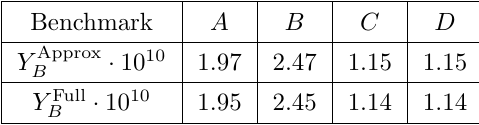
Table 7. Baryon asymmetry generated by each benchmark point using the full and approximate system of transport